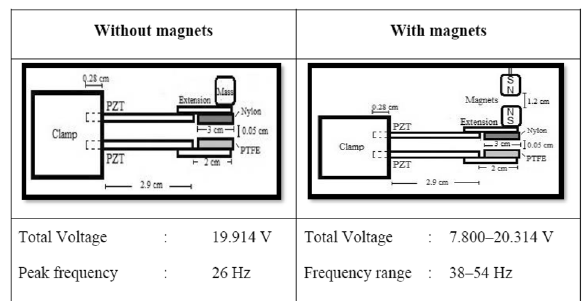
Figure 11. Performance enhancement of MT-HPTEH with magnet